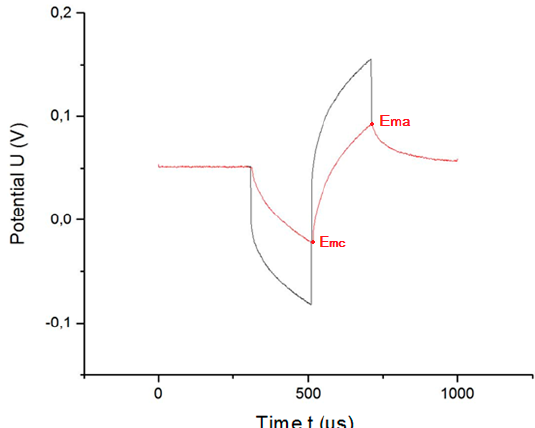
Figure 7. Graphical correction of the access voltage. Black line is original potential transient, and red line is corrected potential transient.